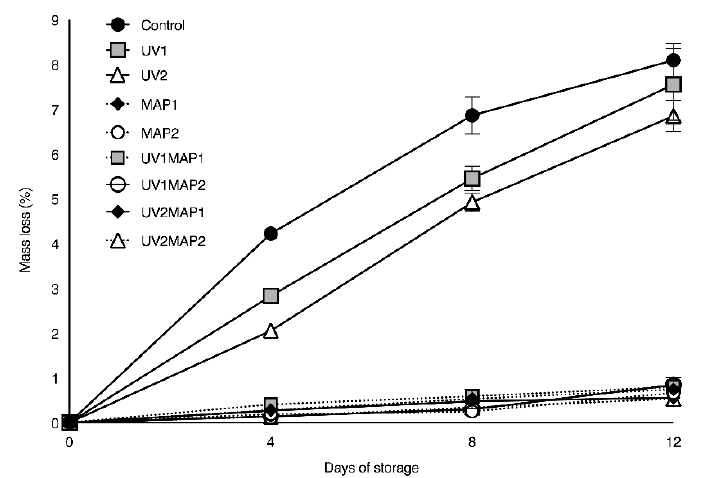
Figure 4. Mass loss during shelf life of red raspberries stored in air (control), treated with UV-C radiation (UV1 or UV2) and packaged in MAP (MAP1 or MAP2). Values represent mean ± standard deviation ( n = 5 packages per batch and control day).